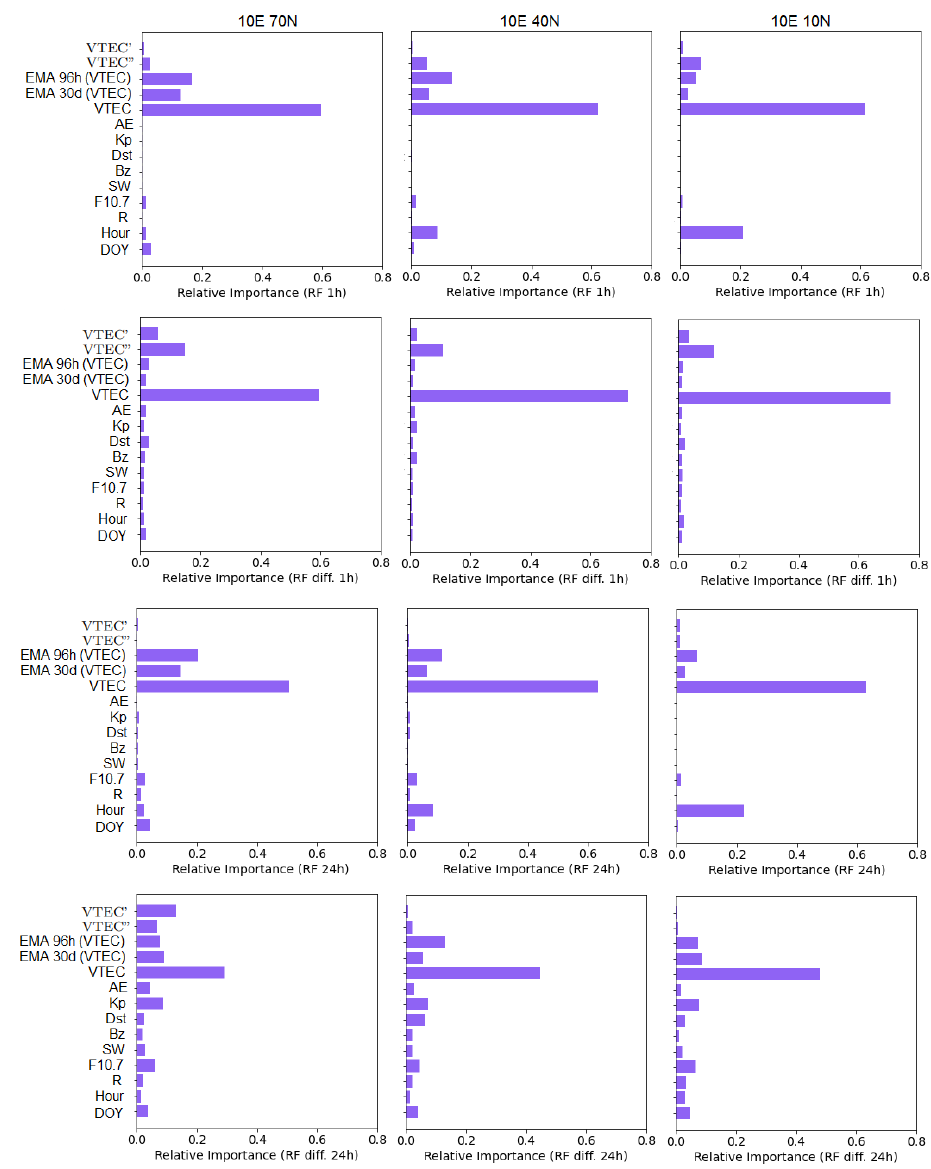
Figure 10. Relative importance of input variables to VTEC forecast estimated from the Random Forest models. Results are presented for 1 h forecast with non-differenced data ( first row ) and differenced data ( second row ), and for 24 h forecast with non-differenced data ( third row ) and differenced data ( fourth row ) for high-latitude ( left ), mid-latitude ( middle ) and low-latitude ( right )